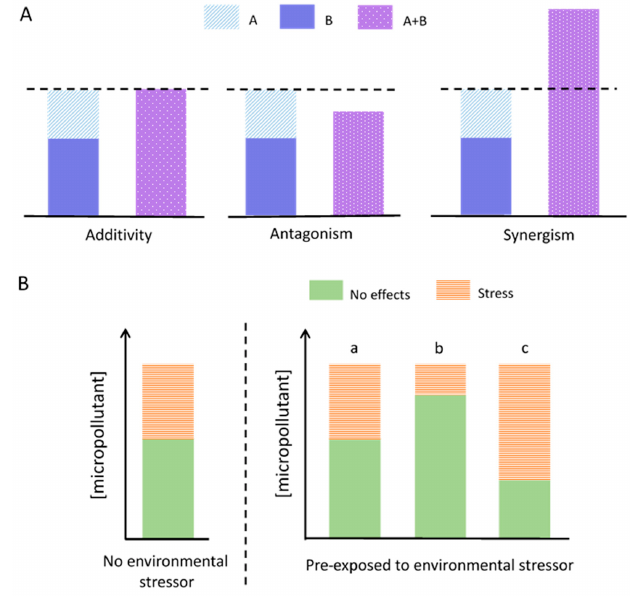
Figure 1. Combined effects of multiple stressors in the environment. ( A ) Illustration of the concepts of additivity, antagonism and synergism; ( B ) Illustration of combined effects that might occur when the microorganism is pre-exposed to environmental stressor and then to micropollutant, for example toxic trace metal. Three cases can be distinguished: (a) organism acclimates to the environmental stressor, but the acclimation does not interfere with the sensitivity to the trace metal; (b) acclimation confers decreased sensitivity to metal; (c) pre-exposure to the environmental stressor increase the sensitivity to the